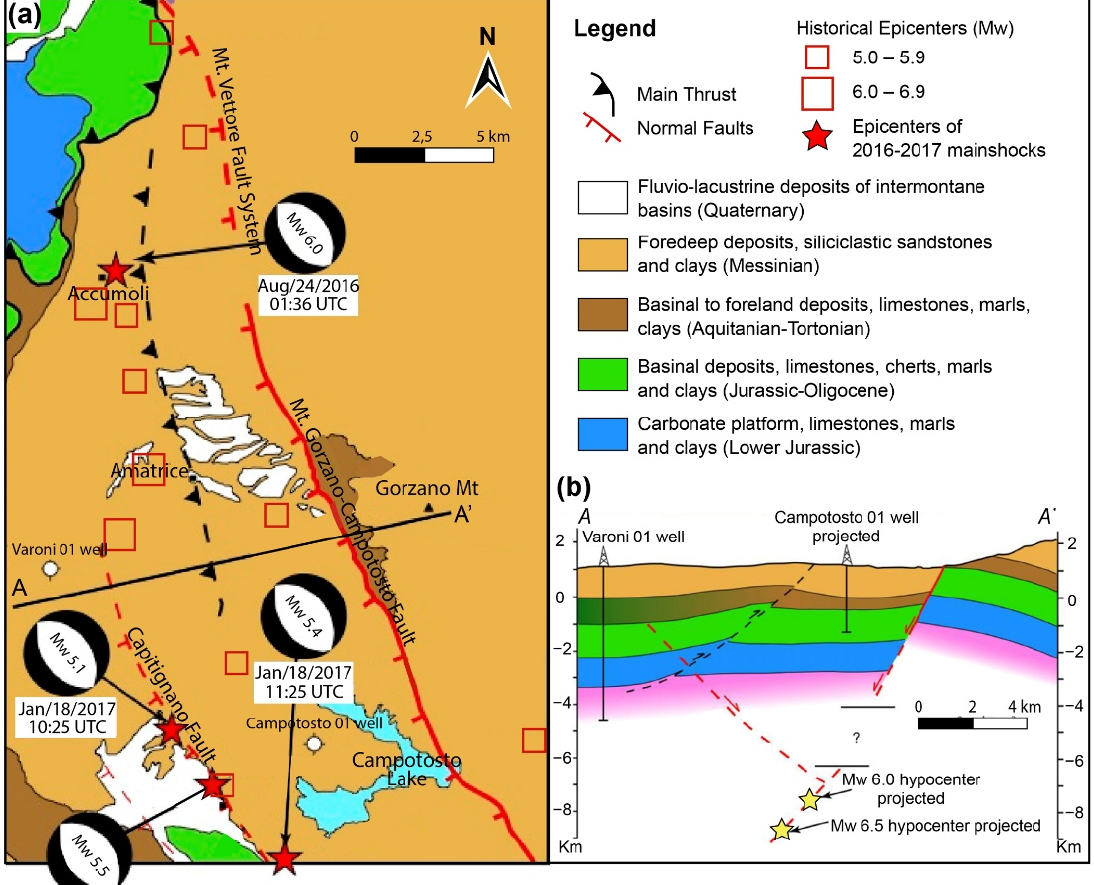
Figure 3. ( a ) Main tectonic lineaments of the Laga Mts. and Lake Campotosto basin; active exten- sional faults in red epicenters and focal mechanisms of events with M w > 5.0 are also shown (modi- fied after [68], reproduced with the permission of Elsevier, Journal of Geodynamics 2020); ( b ) geo- logical cross-sections across the Gorzano Mt. area (from [69], reproduced with the permission